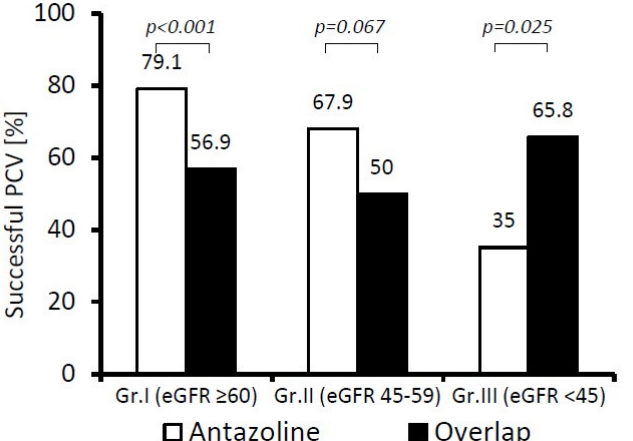
Figure 4. Comparison of pharmacological cardioversion (PCV) effectiveness of antazoline and overlapping therapy at different stages of chronic kidney disease (patients: Group I n = 531; Group II n = 149; Group III n =